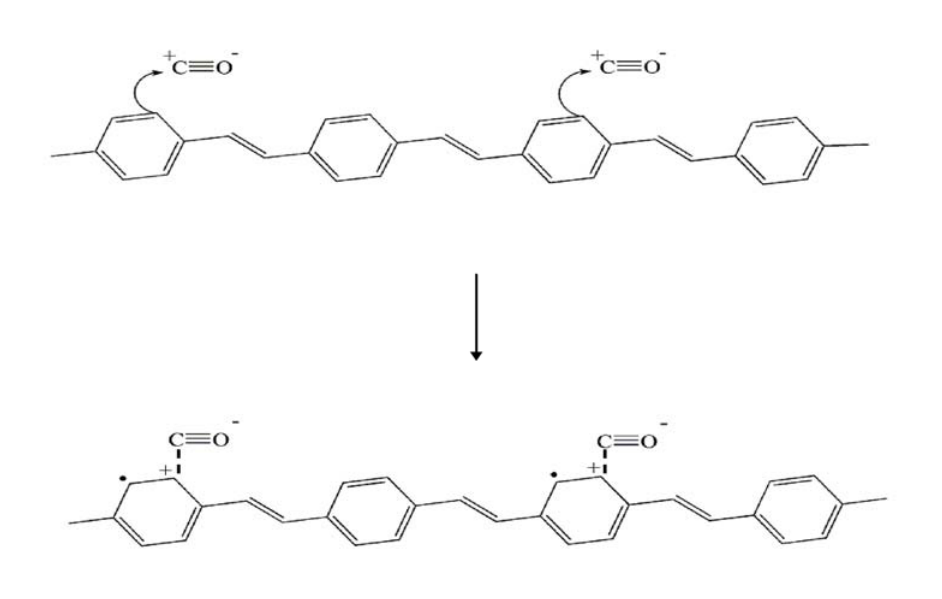
Figure 3. A schematic of the proposed interaction between CO and